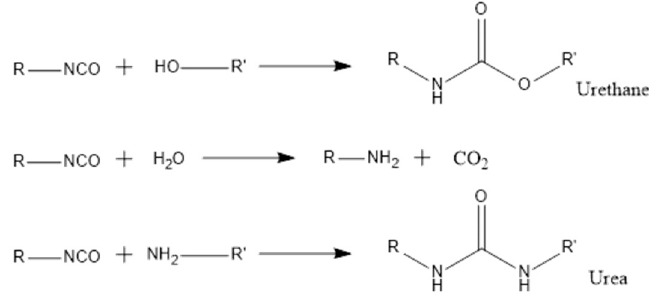
Figure 1. The reaction of isocyanate with hydroxyl group, water, and amino group.